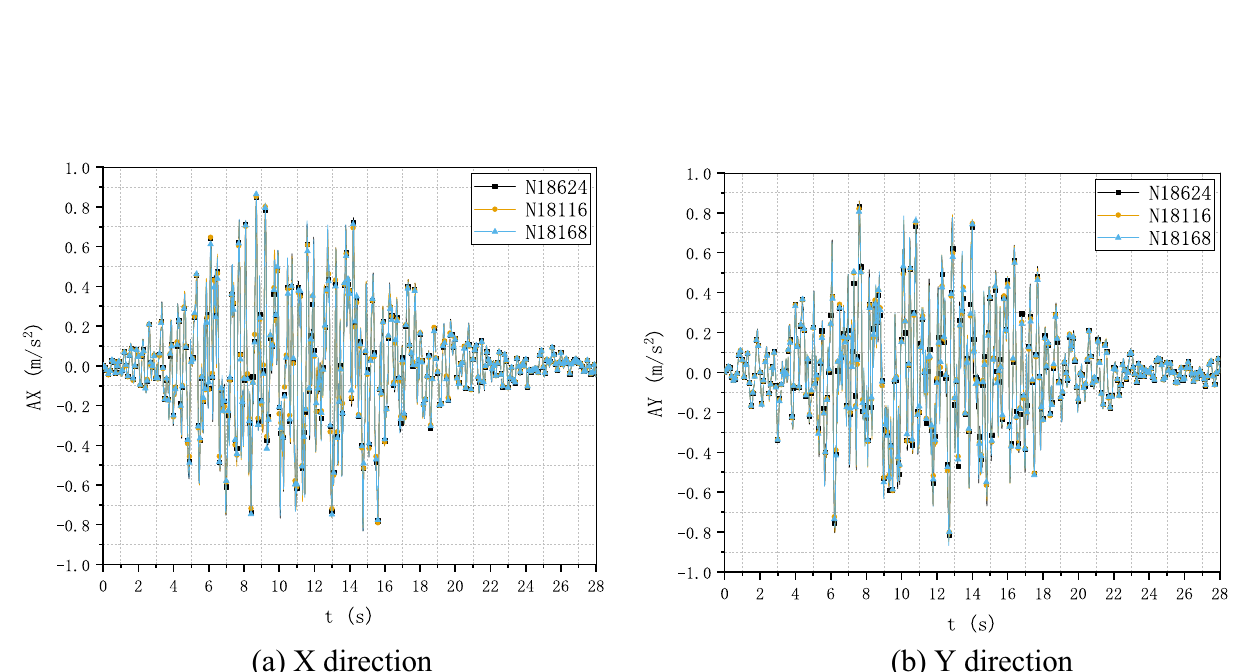
Figure 25. Horizontal acceleration histories of monitoring points at the foundation. ( a ) X direction, ( b ) Y